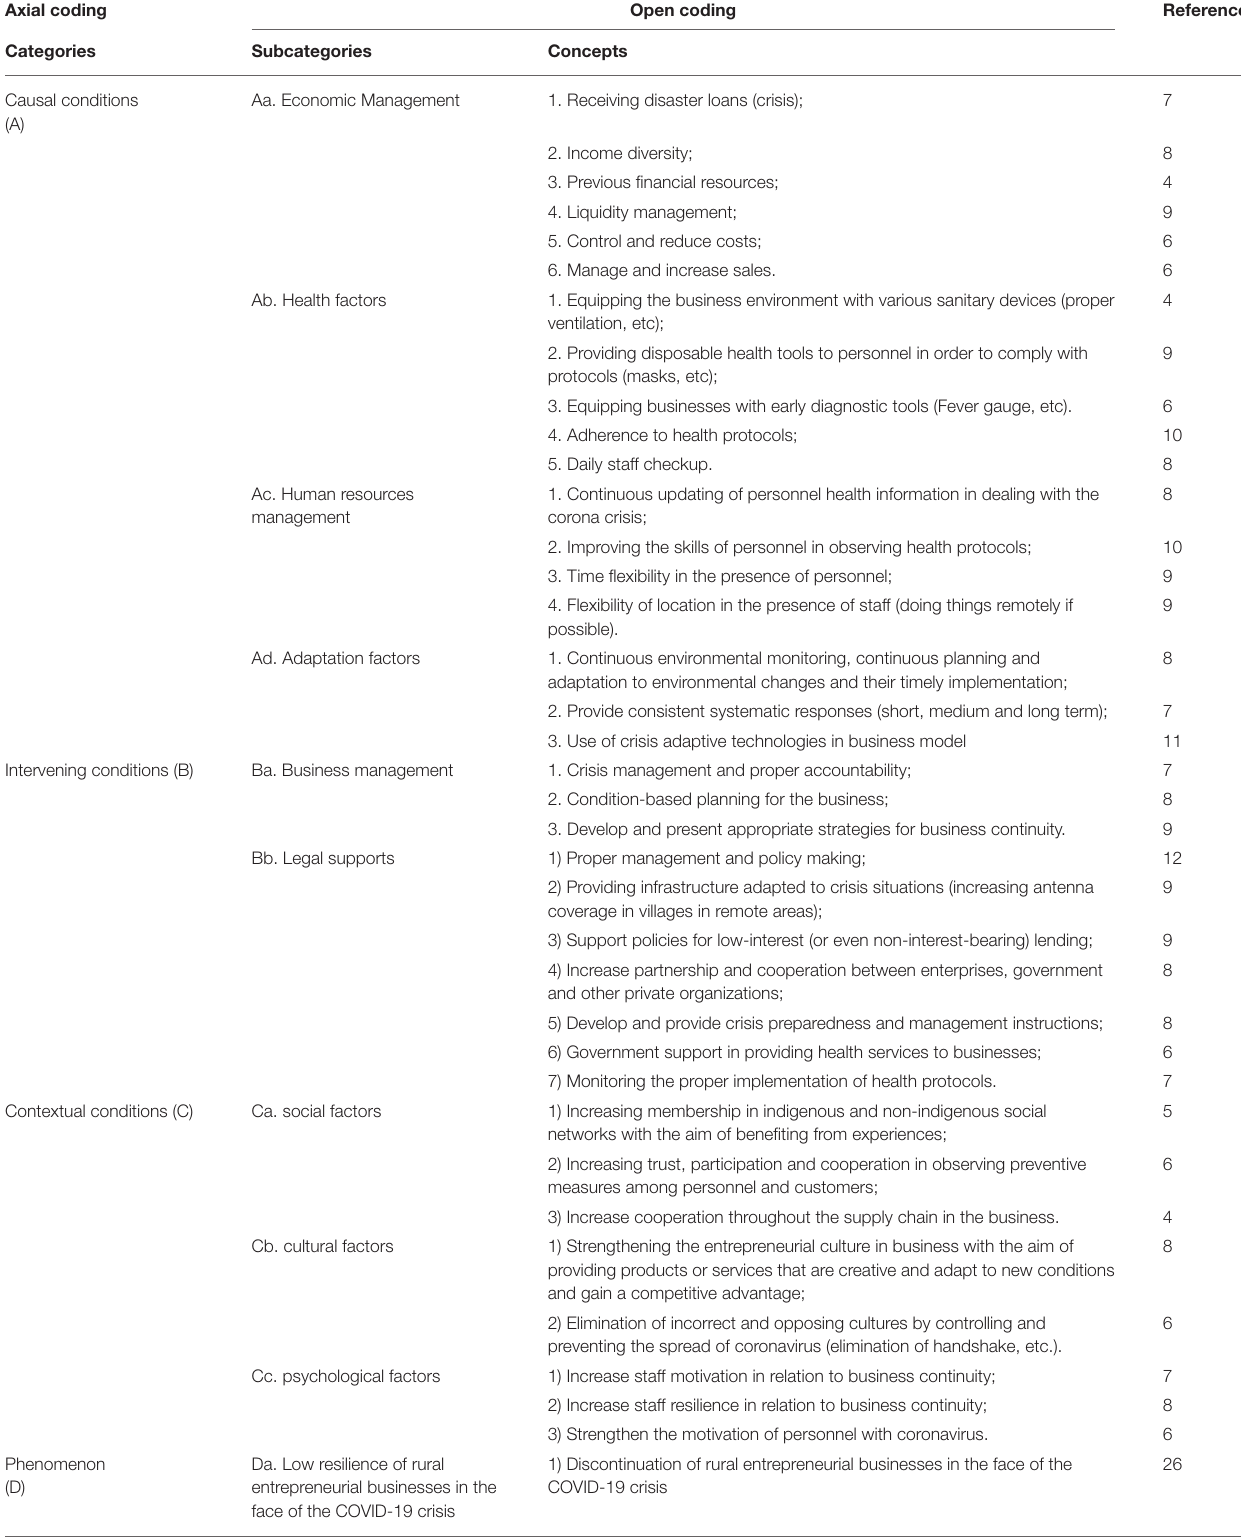
TABLE 1 | Open and axial coding. Axial